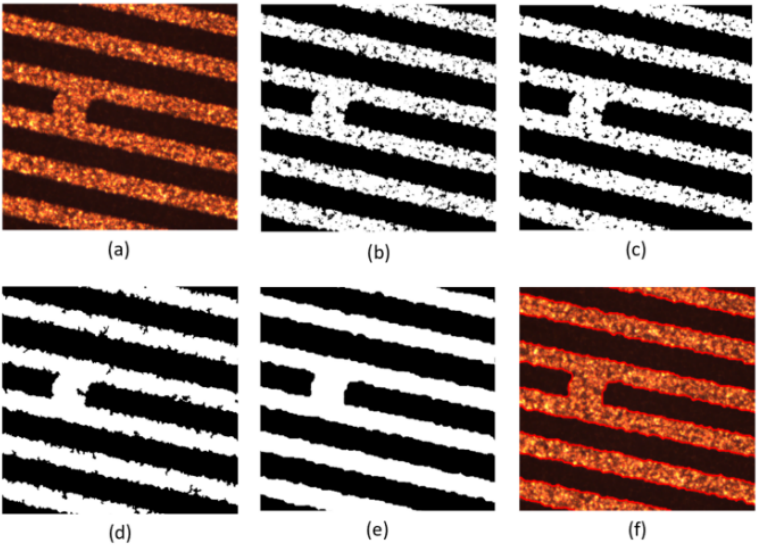
Figure 12. Display diagram of the algorithm for short-circuit defect feature extraction. ( a ) is the original image; ( b ) is the image classified by the K-means algorithm; ( c ) is the image after median filtering; ( d ) is the image after the morphological filling hole algorithm; ( e ) is the image after the closing operation and ( f ) is the image obtained after the feature extraction of the model in this paper.